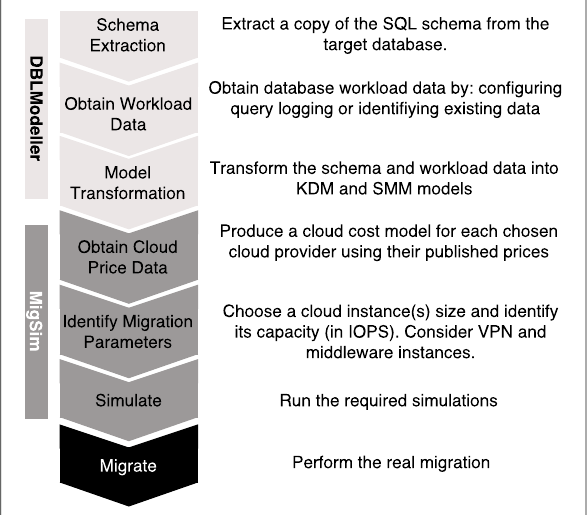
Fig. 1 Two-stage evaluation of cloud database